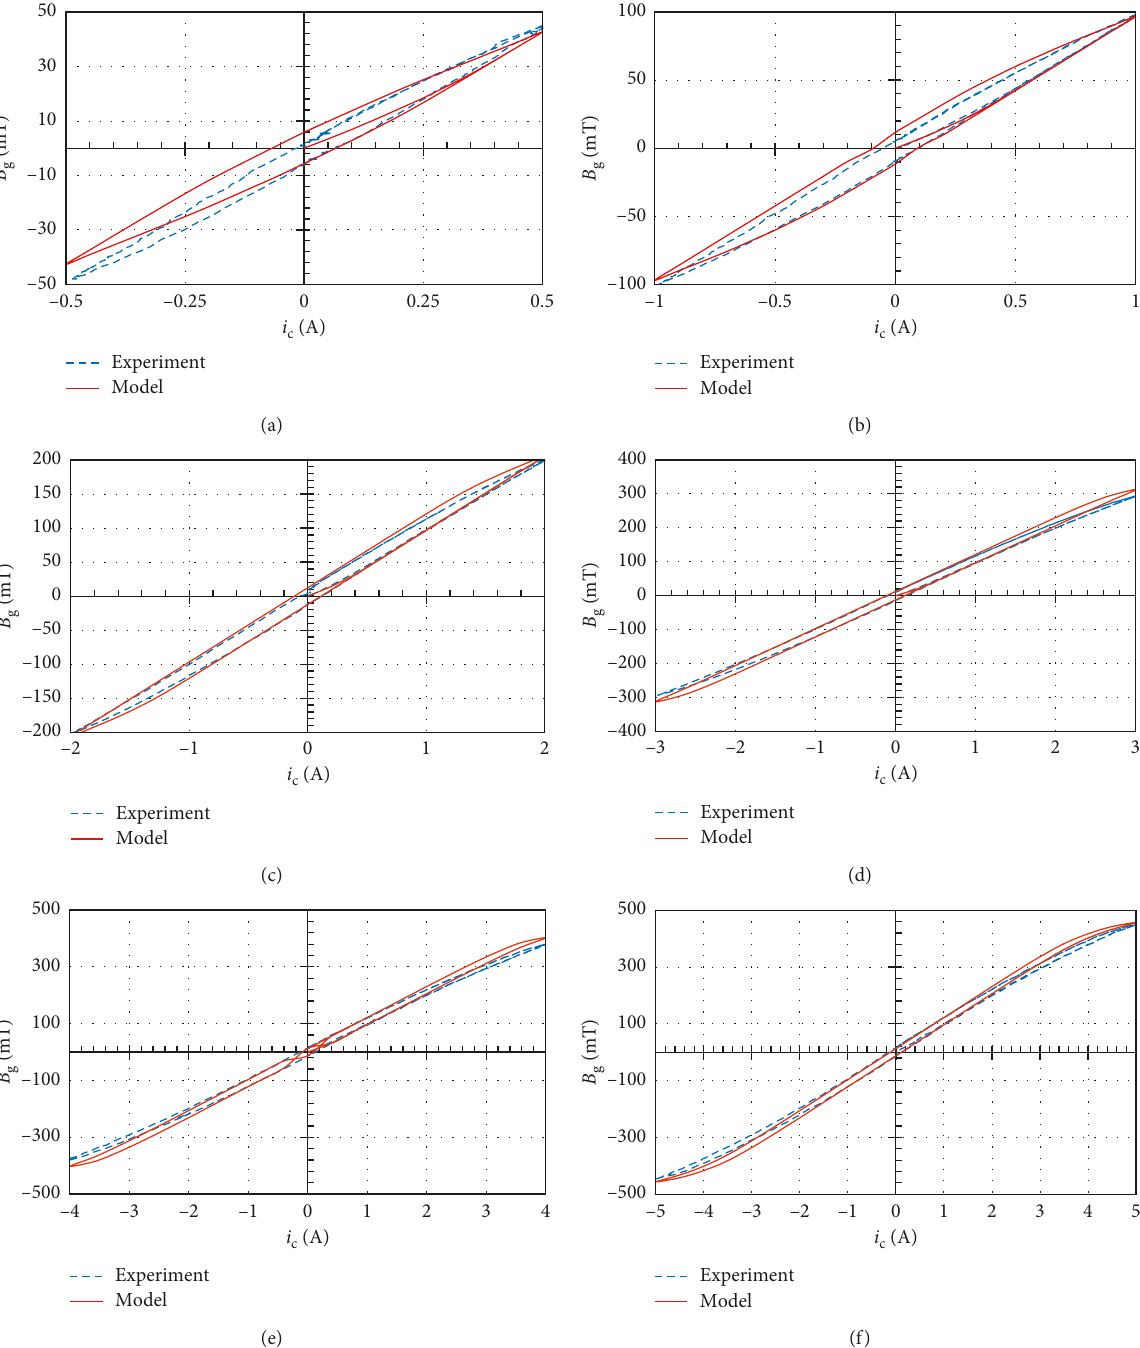
� 0.5A. (b) I � 1.0A. (c) I � 2.0A. (d) I � 3.0A. (e) I � 4.0A. max max max max max